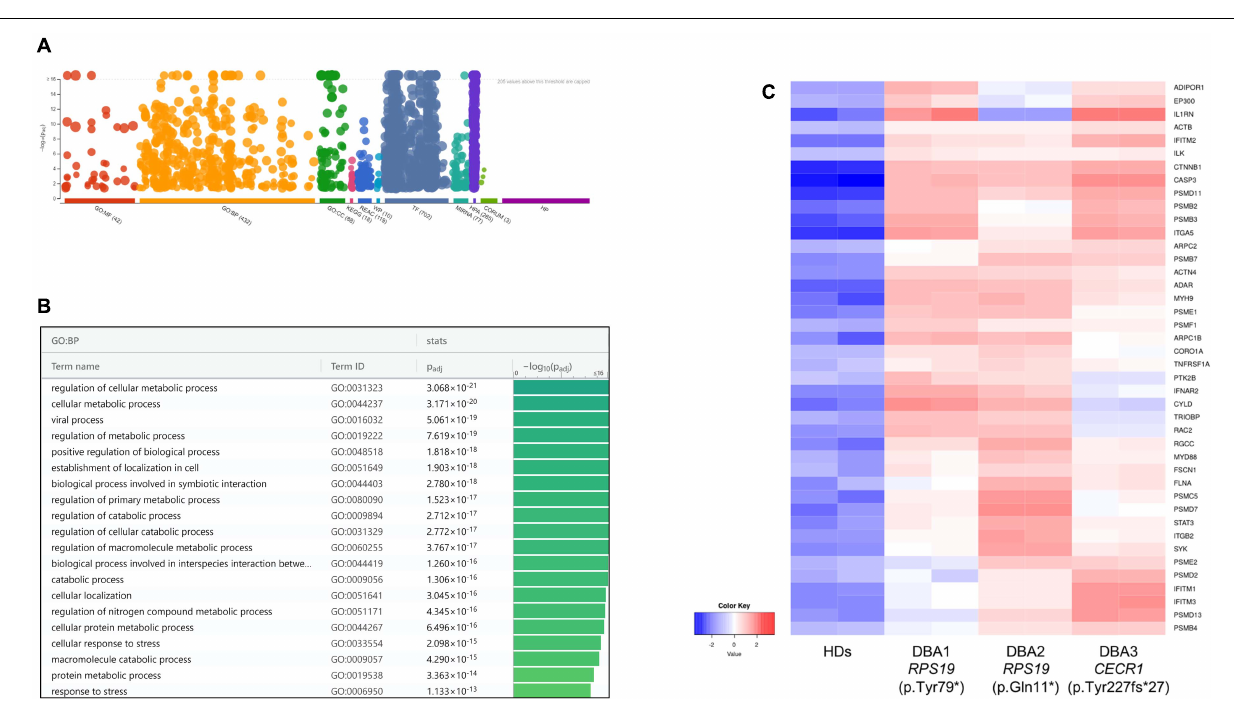
FIGURE 3 | (A) Pathway analysis of the upregulated genes, (B) significant pathways belong to biological process (BP) performed using g:Profiler, (C) differentially expressed genes belong to cellular stress in DBA proerythroblasts. BP: Biological Process, HDs: healthy